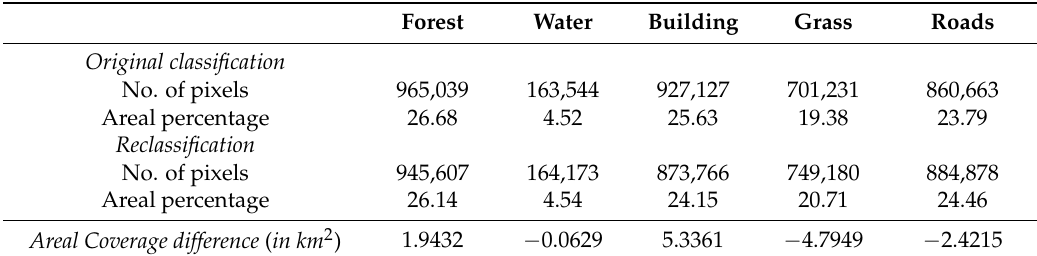
Table 4. Comparison of pixel numbers and areal coverages of the individual LULC classes obtained using original classification and